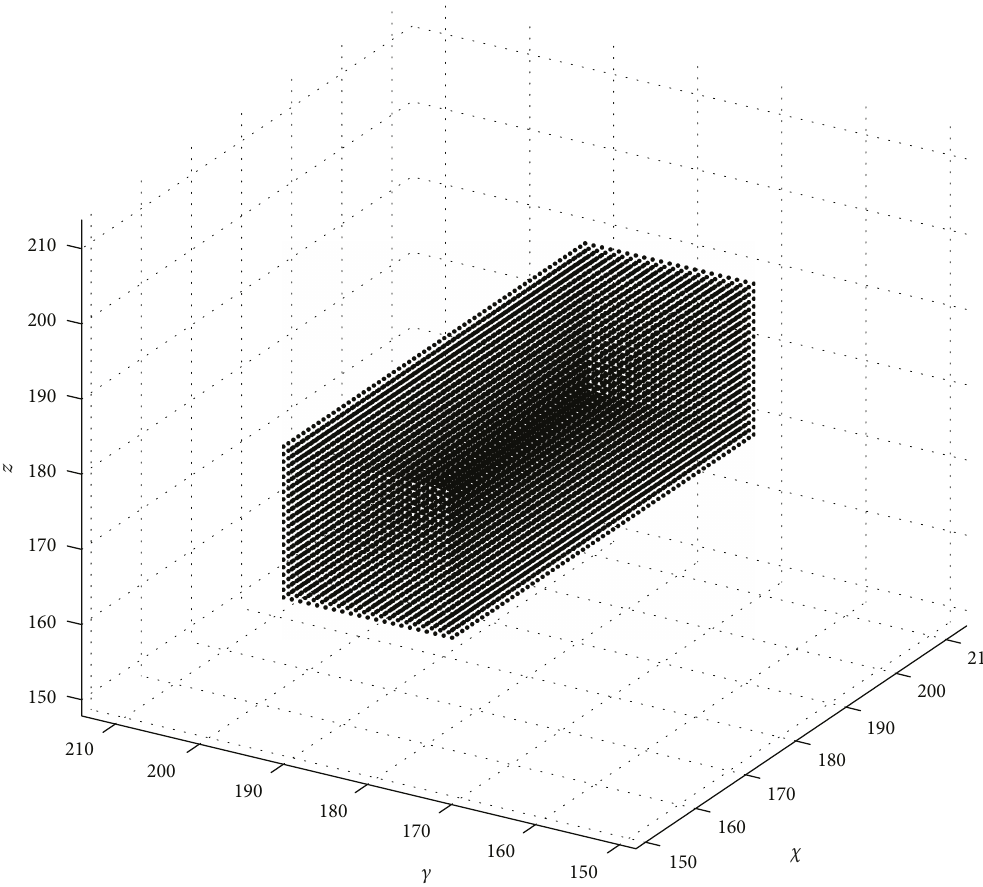
Figure 7: Satellite shape is modelled as a point cloud, which is used to generate a torque pro fi